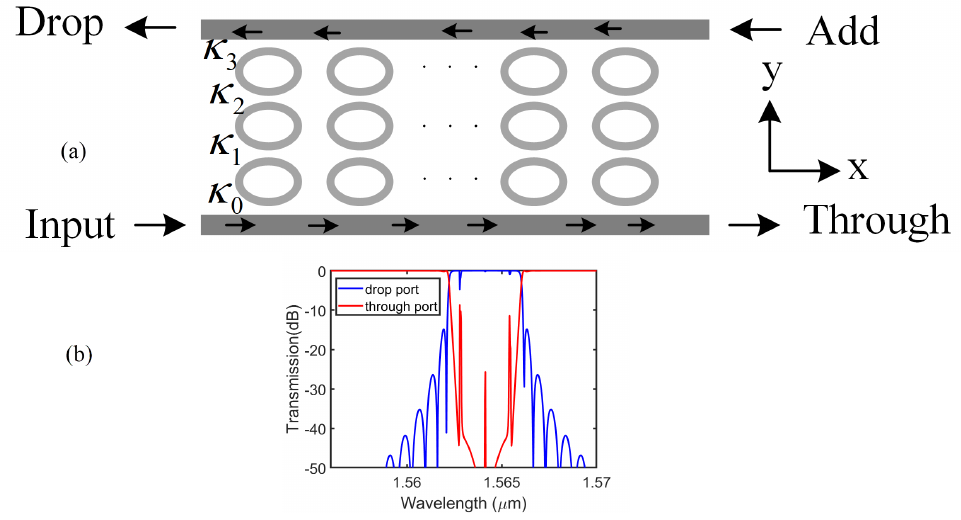
Figure 7. ( a ) Illustration of the 2D array. ( b ) Calculated transmission of the 3 × 20 arrays with different power coupling coefficients [ κ 0 , κ 1 , κ 2 , κ 3 ] = [ 0.112,0.12,0.1,0.1 ] . The blue line indicates the transmission of the drop port, and the red line is the transmission of the through